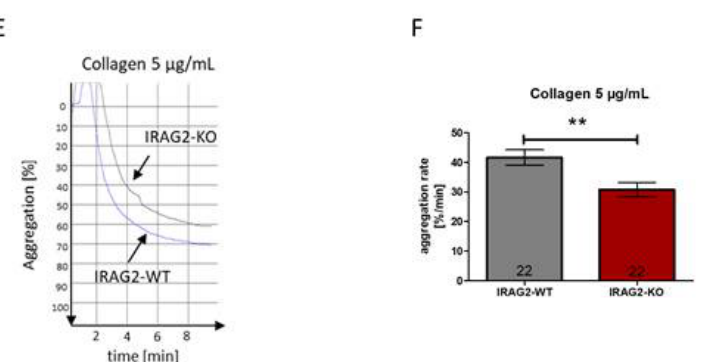
Figure 4. Agonist-induced aggregation of platelets from IRAG2-WT and IRAG2-KO mice. ( A ) Representative traces for aggregation of IRAG2-WT and IRAG2-KO platelets are shown for stimulation with thrombin 0.1 U/mL, where IRAG2-KO platelets revealed a lower aggregability compared to IRAG2-WT platelets. ( B – D ) Statistical evaluation of aggregability revealed a significantly lower aggregation rate for platelets from IRAG2-KO mice compared to platelets from IRAG2-WT mice upon stimulation with thrombin 0.1 U/mL ( B ), thrombin 0.05 U/mL ( C ) and thrombin 0.024 U/mL ( D ). ( E , F ) Representative traces for aggregation of IRAG2-WT and IRAG2-KO platelets upon stimulation with collagen 5 µg/mL ( E ) and statistical evaluation of aggregation rate upon stimulation with collagen 5 µg/mL ( F ) showed a significantly lower aggregability of IRAG2-KO platelets compared to IRAG2-WT platelets. Aggregation rate is calculated as maximal slope of the curve. For each aggregation 1.0 × 10 8 platelets/mL were used. Number of performed experiments (number of mice) are shown in the graphs and mean ± SEM is shown by bars. Significant differences are indicated as (*) ( p < 0.05) and (**) ( p <